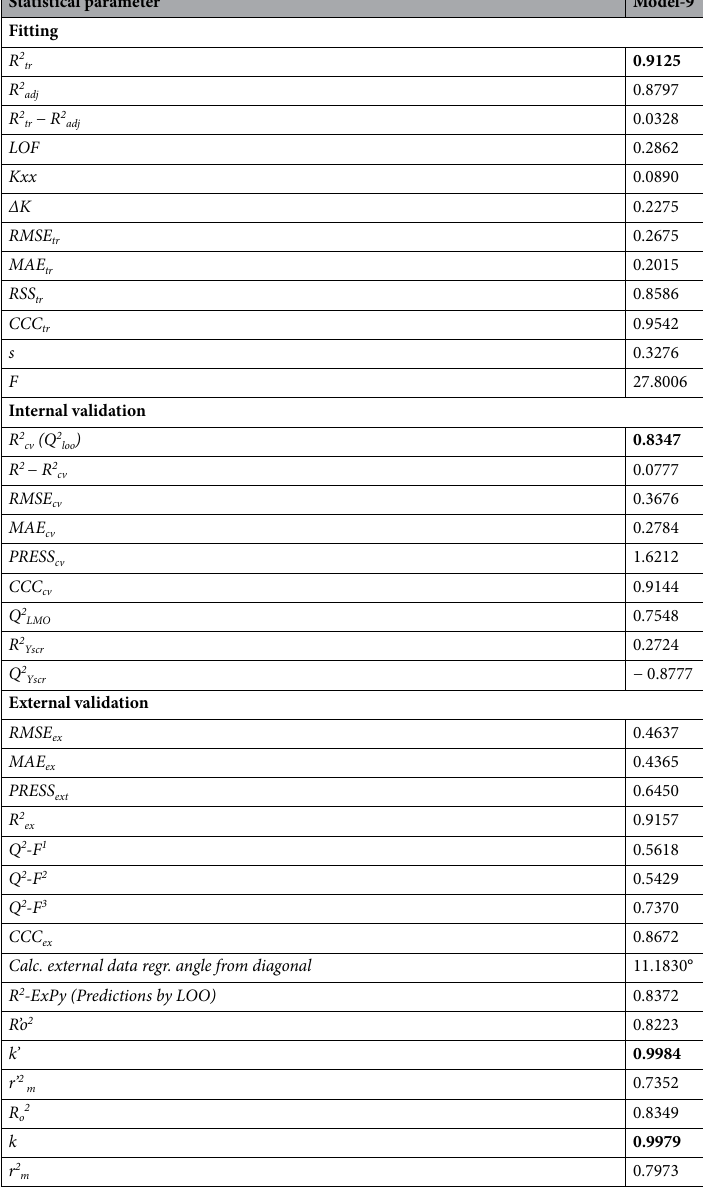
Table 5. Modelling results for selected QSARINS models with Variable 3 along with their statistical validations. *The statistical quality and strength of a GA-MLR based QSAR model was determined on the basis of: (a) internal validation based on leave-one-out (LOO) and leave- many-out (LMO) procedure (i.e. cross-validation (CV)); (b) using external validation; (c) Y-randomization (or Y-scrambling); and (d) fulfilling of respective threshold value for the statistical parameters: R 2 r 2 m ≥ 0.6, (1- r 2 / r o2 ) < 0.1, 0.9 ≤ k ≤ 1.1 or (1- r 2 / r ’ o2 ) < 0.1, 0.9 ≤ k ’ ≤ 1.1,| r o2 − r ’ o2 |< 0.3 with RMSE and MAE close to zero. Significant values are in